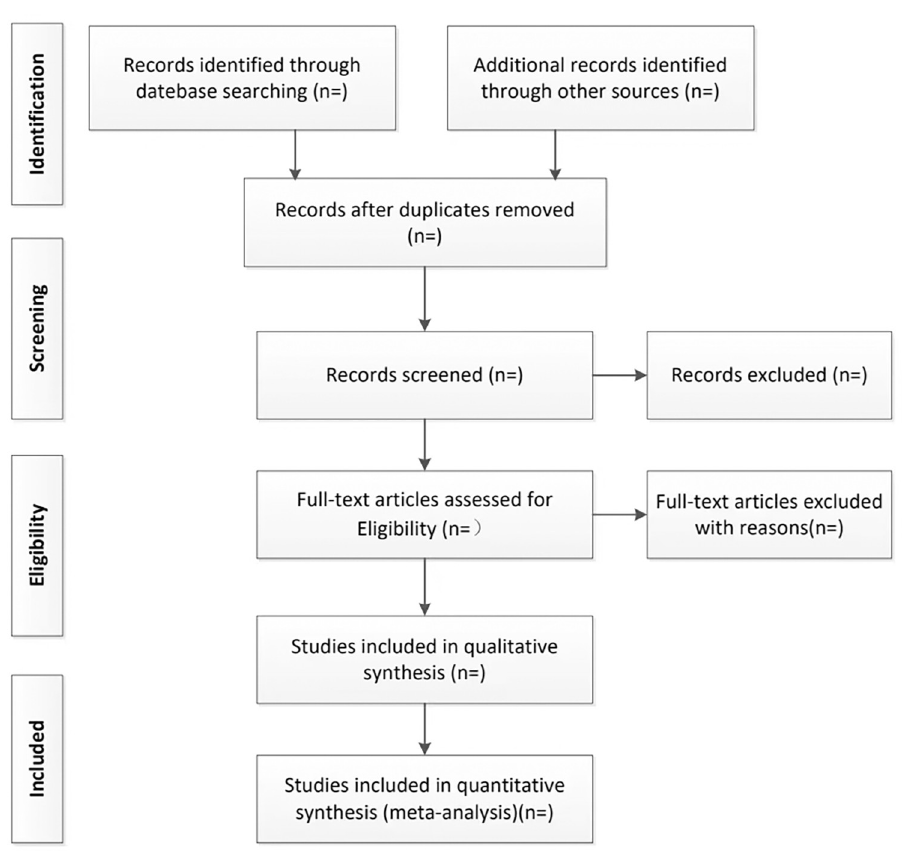
Fig 1. Flowchart of study